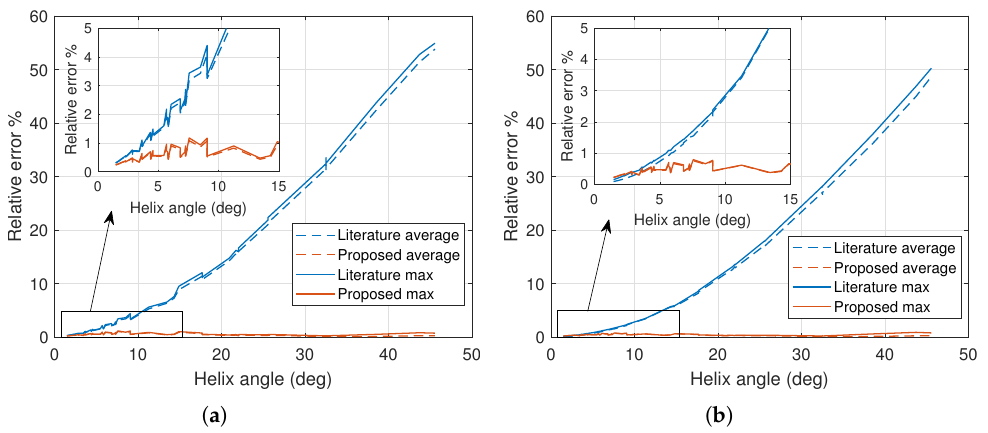
Figure 10. Relative errors committed by using the Eureqa solution and the literature formula on the first principal curvature radius of the ( a ) screw shaft and ( b ) nut grooves for various off- the-shelf commercial ball screws, ordered against the helix angle (numerical results are listed in Tables A1 and